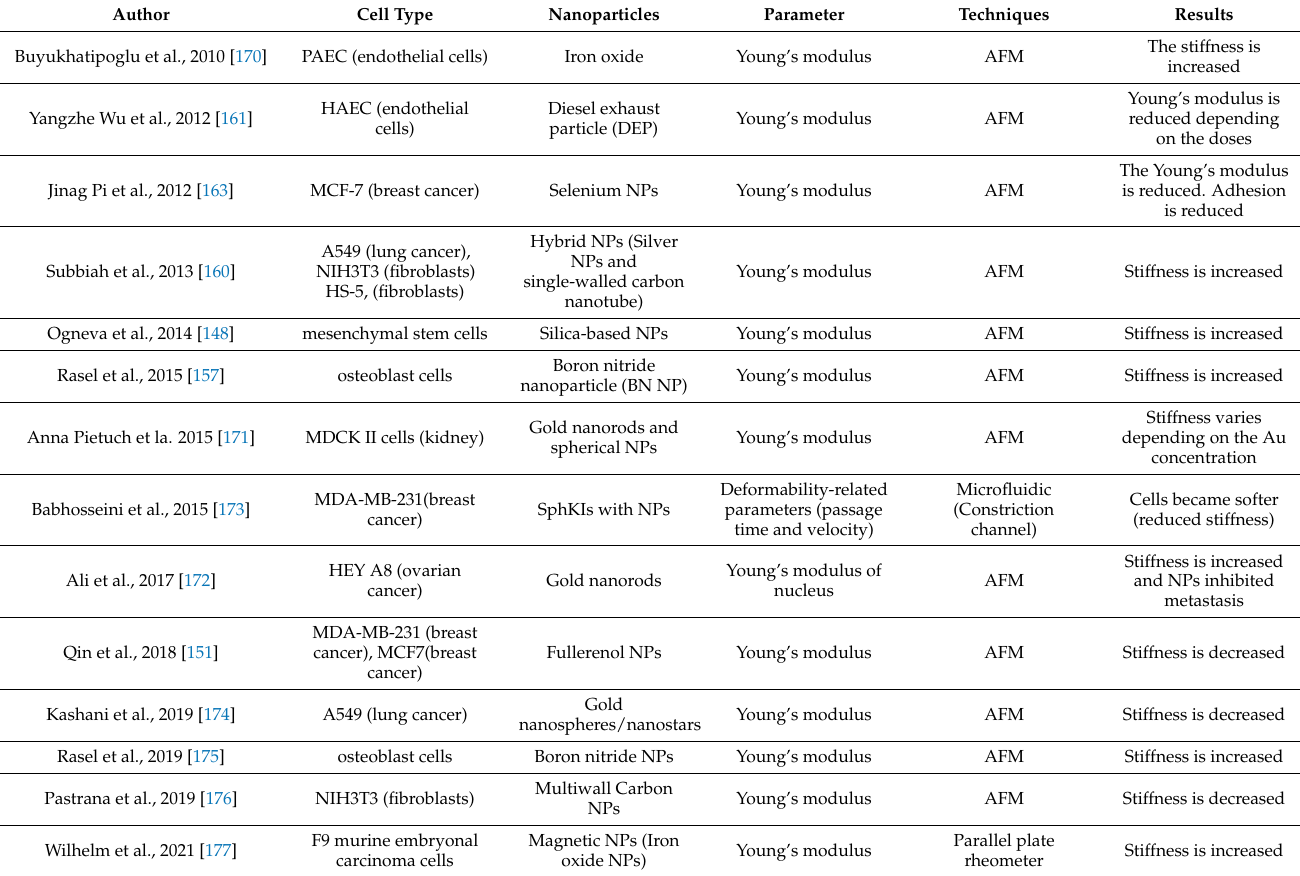
Table 3. Effects of various NPs on the mechanobiological properties (stiffness) of